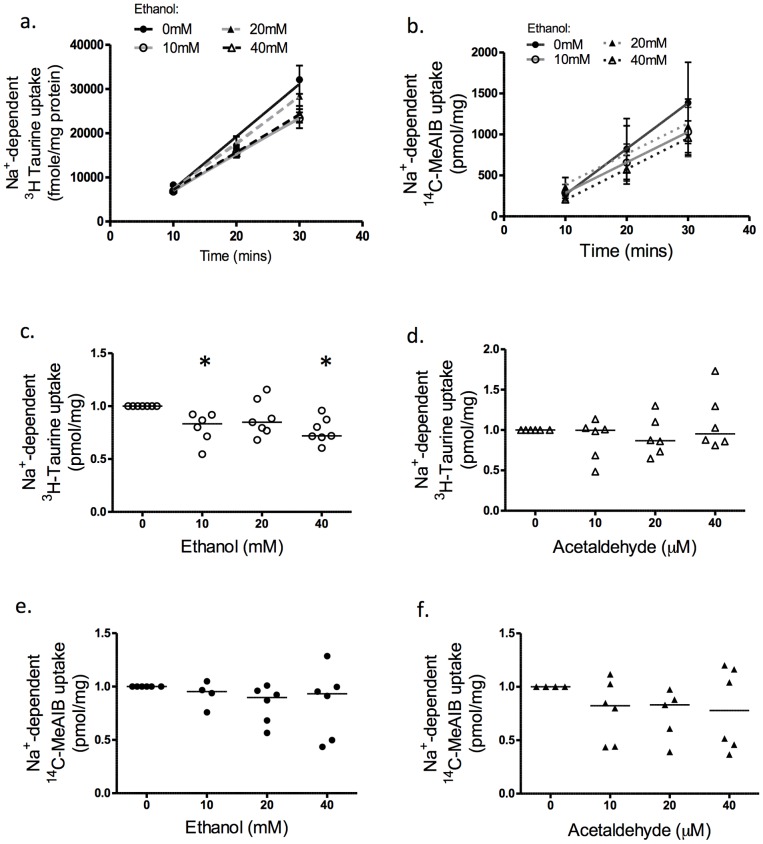
Effect of alcohol and acetaldehyde on system β and System A activity in BeWo cells.Na+-dependent 3H taurine uptake (system β activity) and Na+-dependent 14C-MeAIB uptake (system A activity) of BeWo cells over time. (a) system β activity and (b) system A activity, over 10, 20 and 30 minutes (Mean 23282±4809, SE = 2151, N = 6). The least squares linear regression shows that uptake was linearly related to time in all cases (p≤0.05). (c) System β activity of BeWo cells at 30 minutes. Ethanol treatment at 10 mM and 40 mM significantly decreased transporter activity (p<0.05; N = 6). (d) Acetaldehyde exposure did not change system β activity after 30 minutes (N = 6; p>0.05). (e) System A activity was not affected by ethanol or (f) acetaldehyde (N = 6; p>0.05). Statistical analysis with Wilcoxon signed-rank. *p<0.05 vs control.